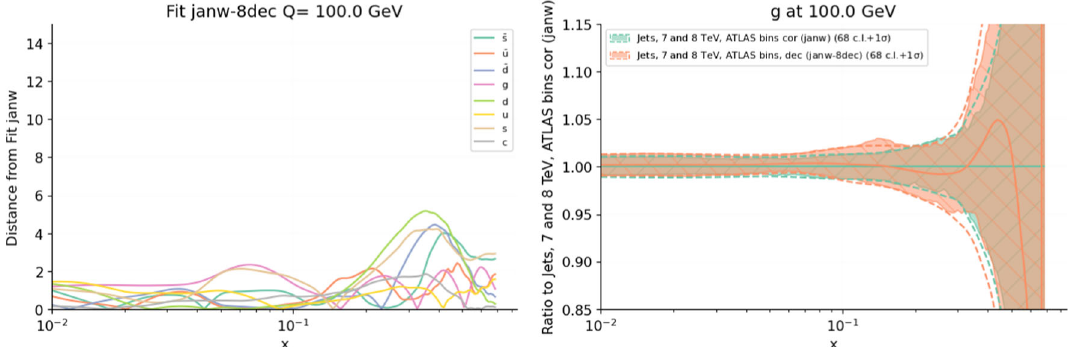
Fig. 12 Same as Fig. 6, but now comparing the default most accurate fit to single-inclusive jet data (all datasets, NNLO QCD+EW, fit #janw), to a fit in which selected systematic uncertainties are decorrelated in the ATLAS 8 TeV data (fit #janw-8dec). The gluon is shown as ratio to the